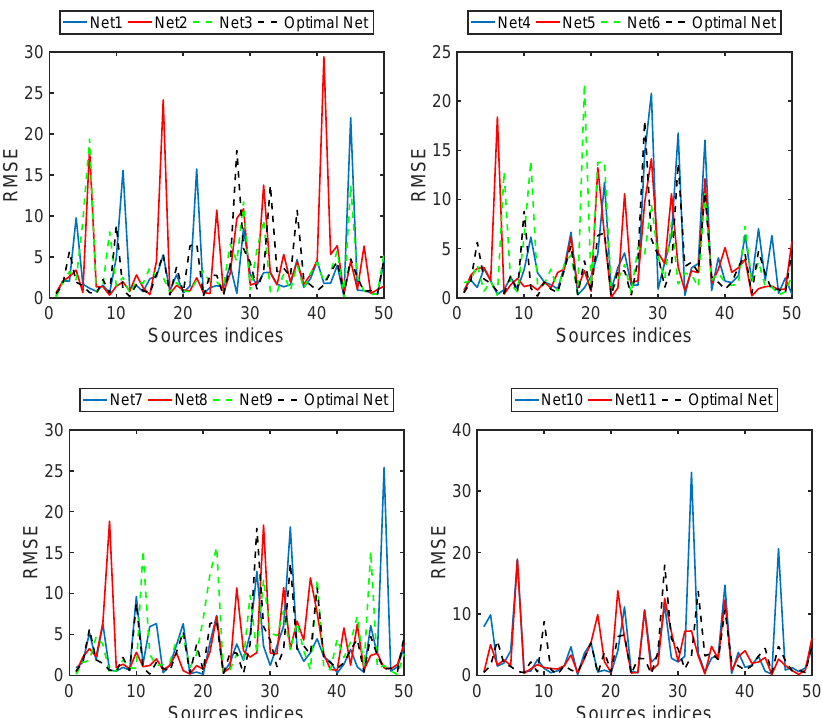
Figure 8. Root mean square errors for all the tested networks. The results are obtained for 50 sources whose components were selected from uniform distributions.